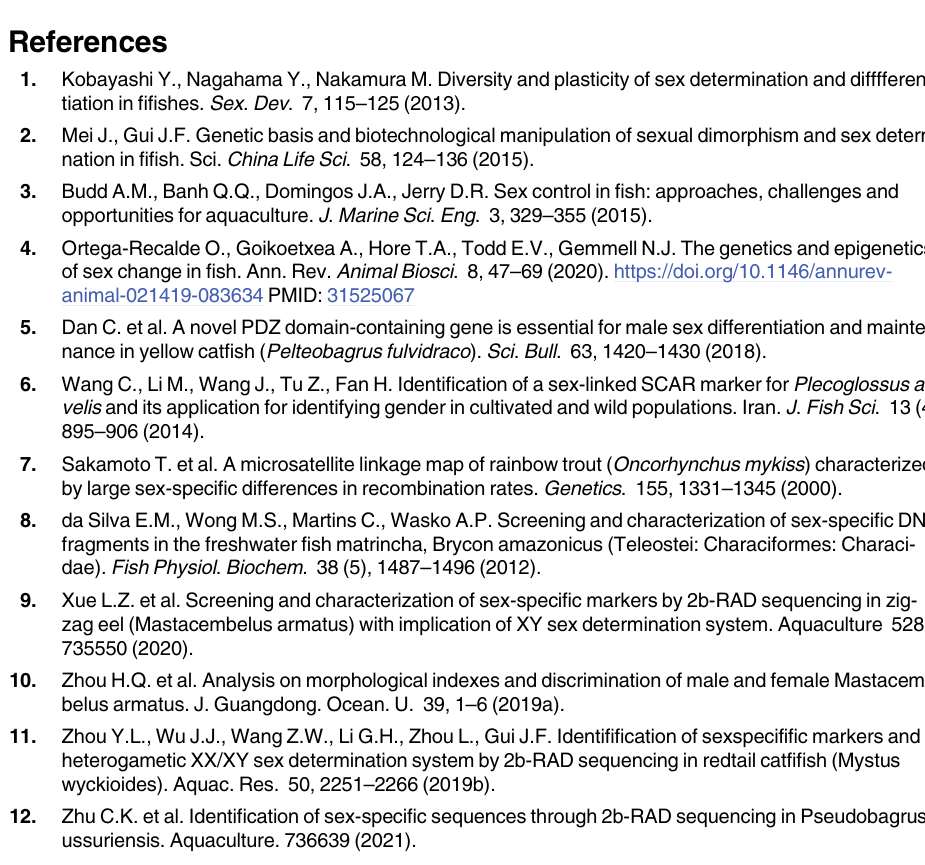
S1 Table. Primers used to verify candidate male-specific 2b-RAD-tags and sex-specific SNP